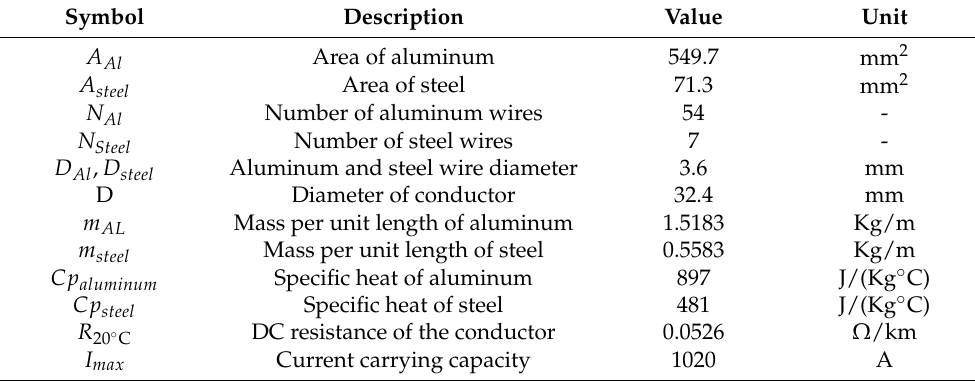
Table 3. Parameters of the tested ACSR conductor 550-AL1/71-ST1A.